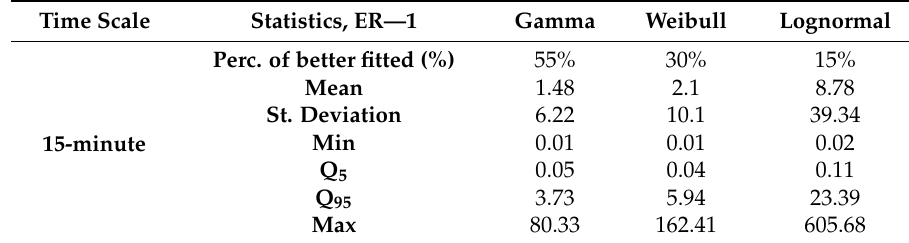
Table A3. Summary statistics of the three error measures that evaluate the fitting performance of the distributions along with the percentage of the records in which each distribution is better fitted. Q 5 and Q 95 is the 5% and 95% empirical quantile points,